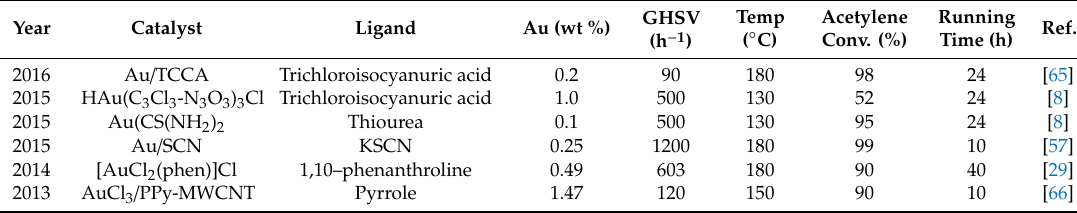
Table 2. Au catalysts prepared with di ff erent ligand